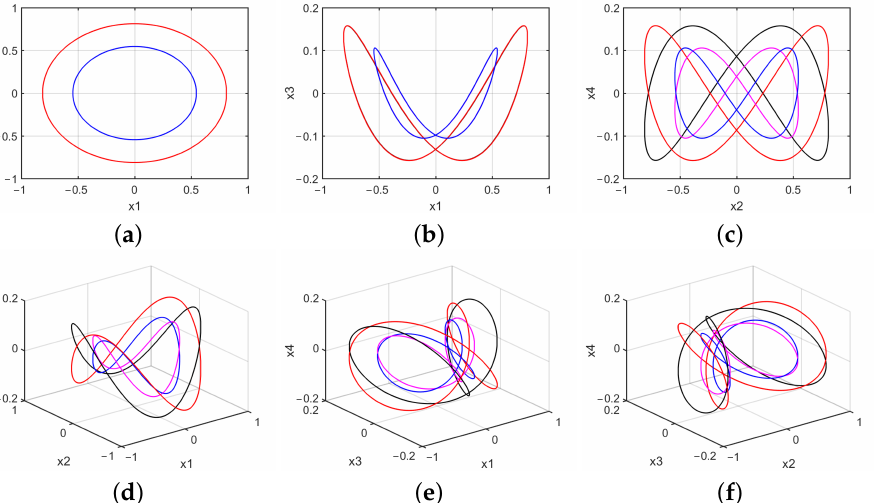
Figure 8. Morphology and relative positions of four periodic solutions when f 1 = 12 > f 12 : ( a ) ( x ) plane; ( b ) ( x ) plane; ( c ) ( x 1 , x 2 1 , x 3 ( x ) 2 , x 3 , x 4